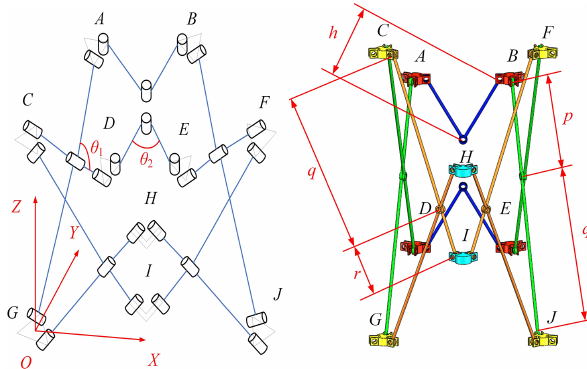
Figure 4. Schematic diagram of the deployable mechanism unit.